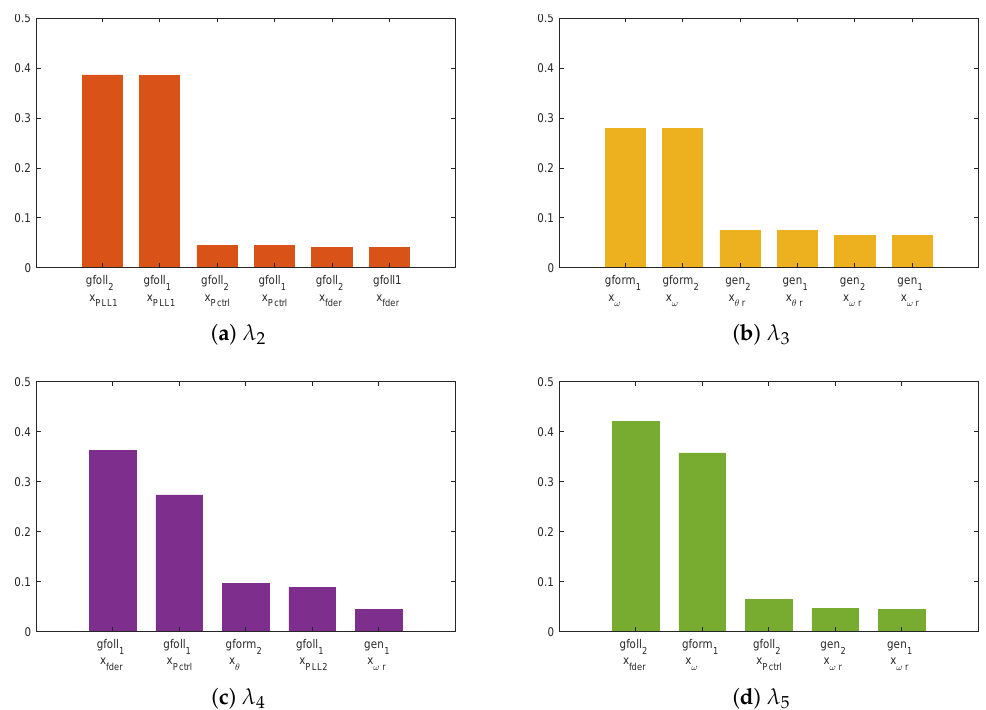
Figure 8. Participation factors for the identified modes in the electromechanical oscillations region: ( a ) grid-following in both areas; ( b ) grid-forming in both areas; ( c ) grid-following in Area 1 and grid-forming in Area 2; ( d ) grid-forming in Area 1 and grid-following in Area 2.